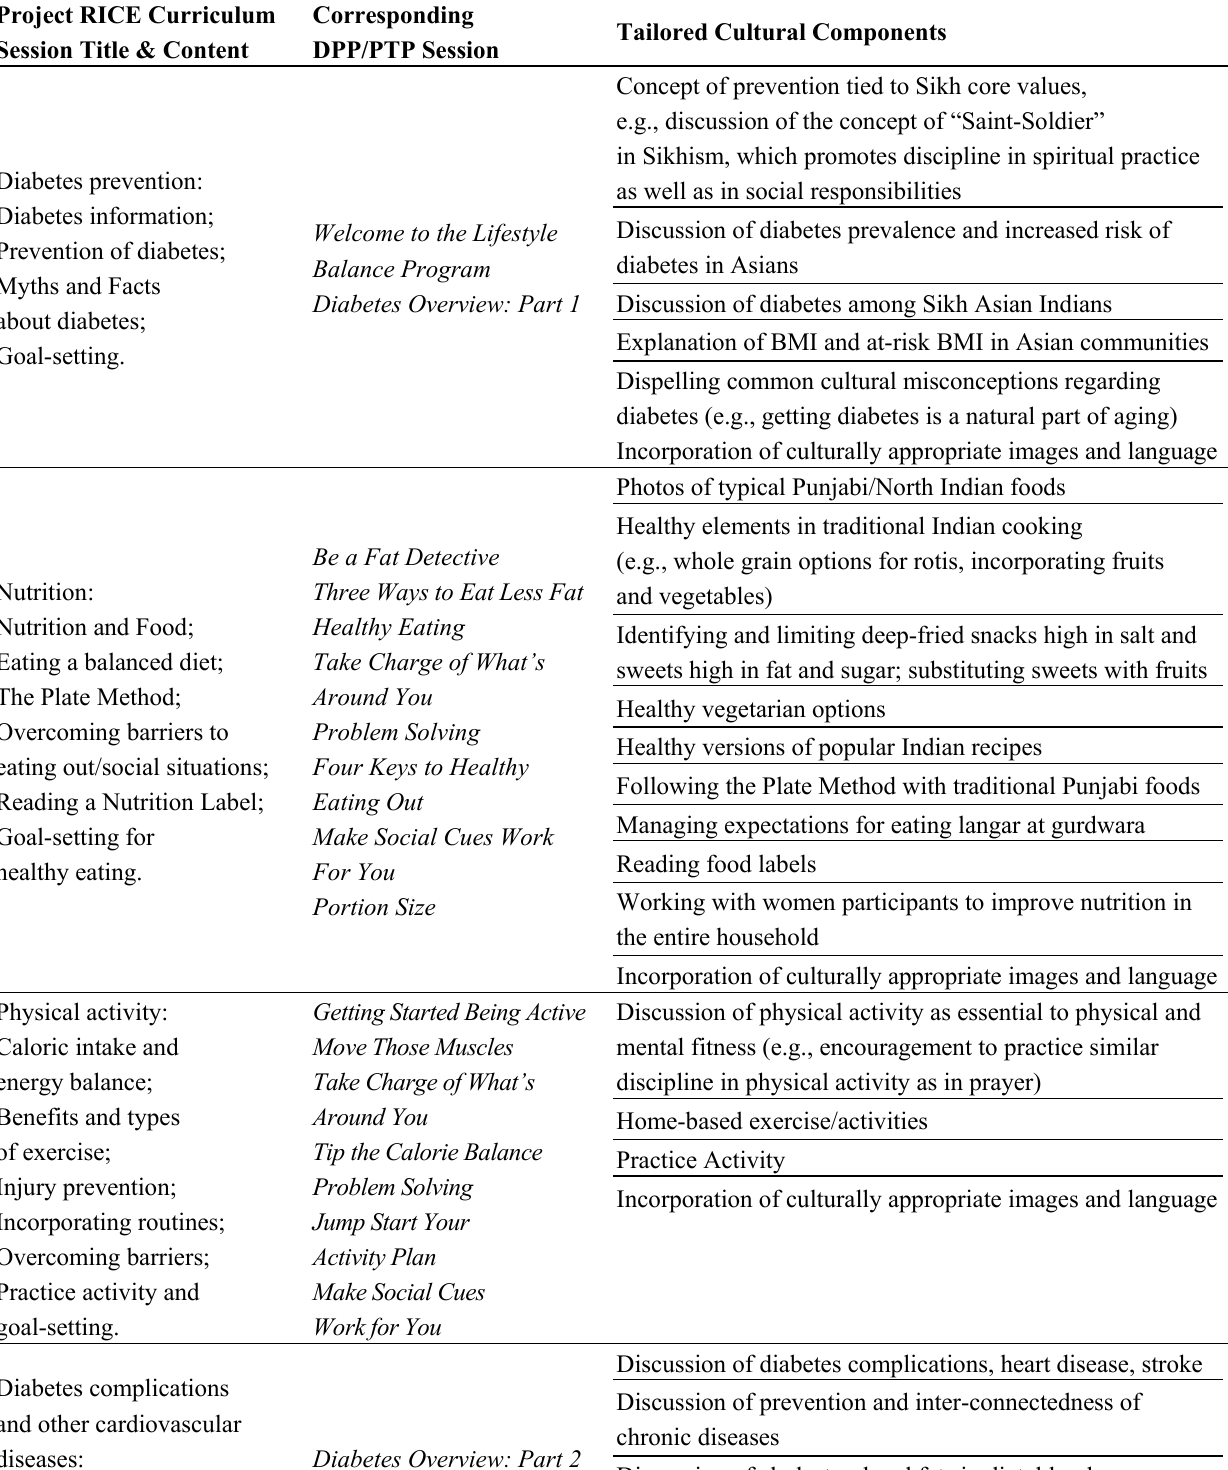
Table 2. Adaptation and Culturally Tailored Components of